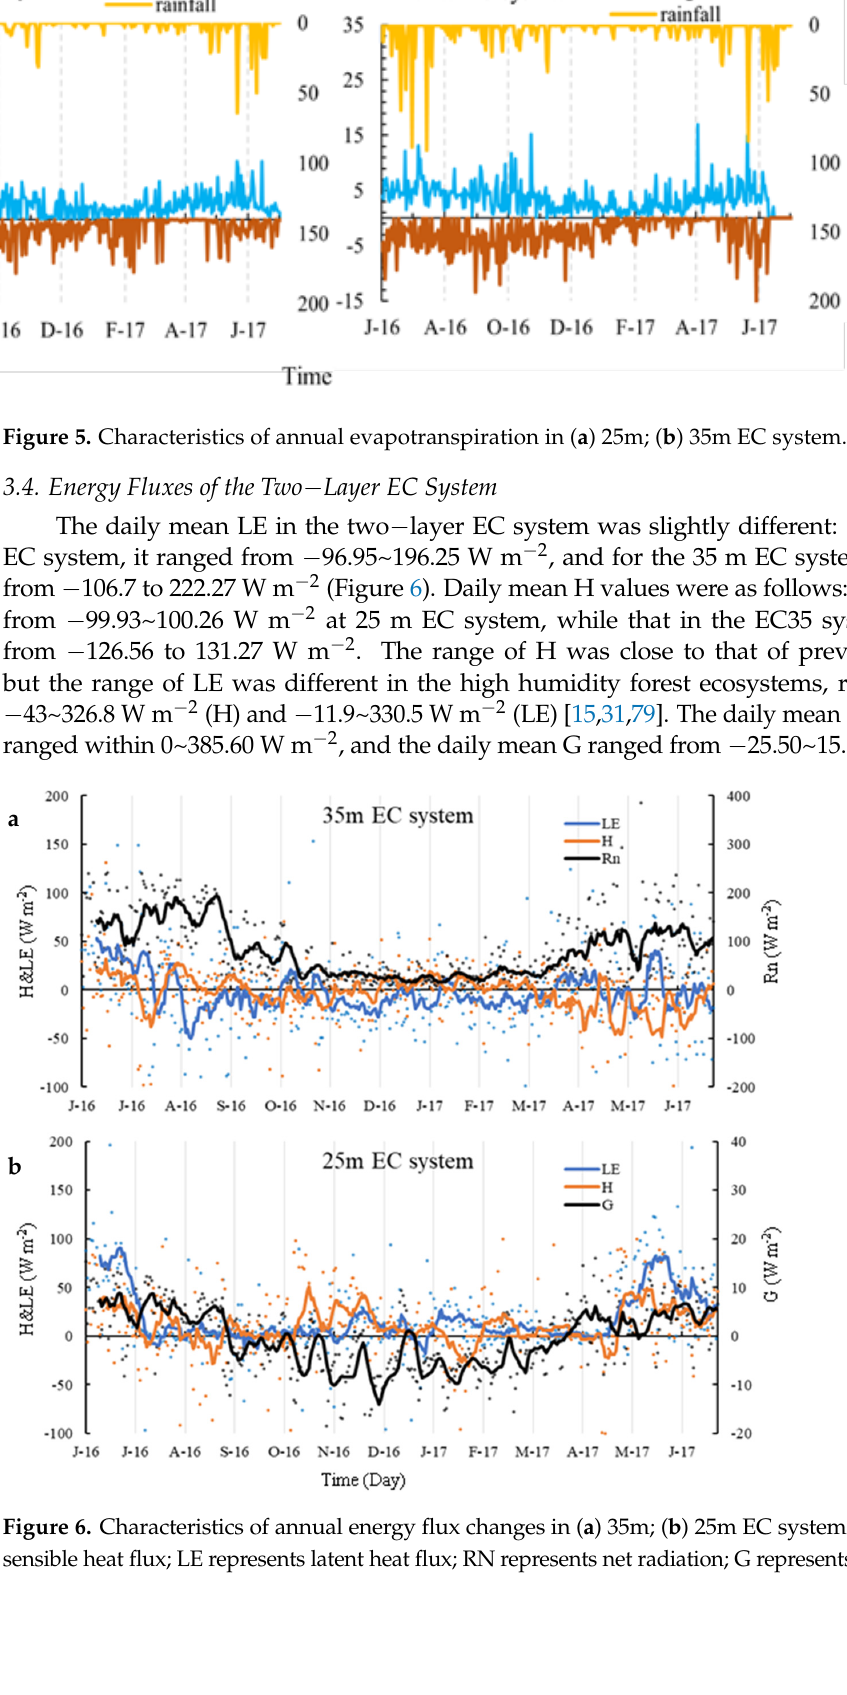
Figure 6. Characteristics of annual energy flux changes in ( a ) 35m; ( b ) 25m EC system. H represents sensible heat flux; LE represents latent heat flux; RN represents net radiation; G represents soil heat flux.